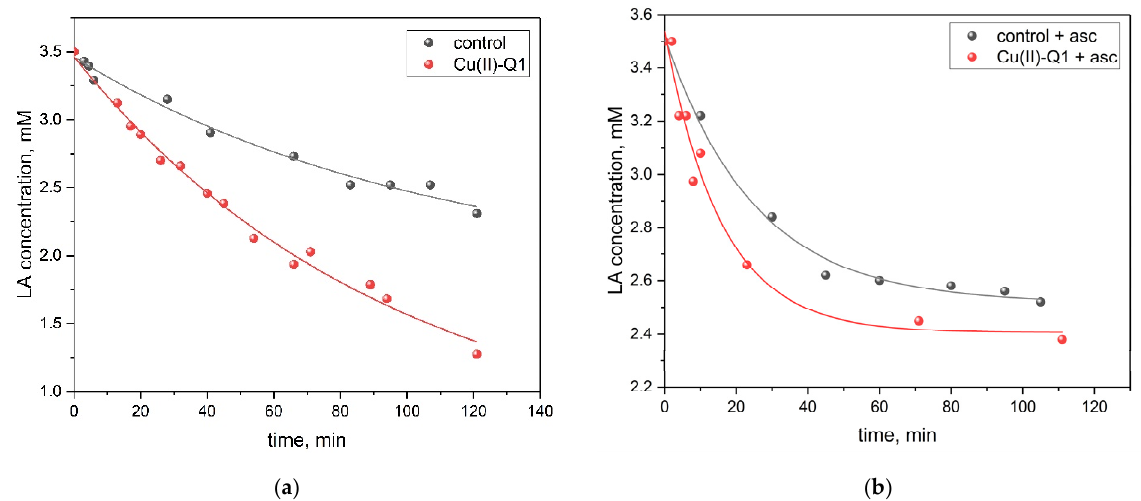
Figure 6. Kinetics of the initiation reaction of LA peroxidation in the absence and presence of the copper complexes of Q1 (see Materials and Methods for details), either: ( a ) without ascorbate, ( b ) with 2.5 mM ascorbate at 25 °C. Table 3. Rate constants for the initiation reaction of LA peroxidation in micelles induced by the Q1 copper complexes relative to the control (i.e., unchelated Cu(II) added as CuCl2) in the presence and absence of ascorbate (2.5 mM).